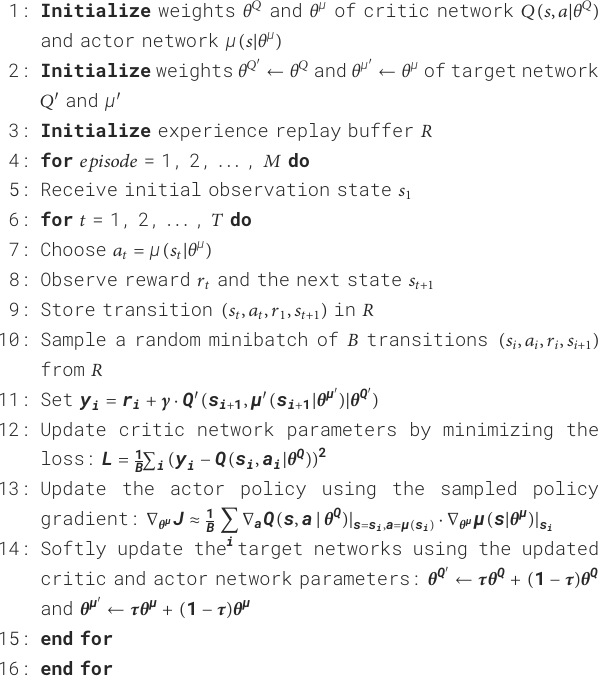
Algorithm 1. DDPG-based learning algorithm.